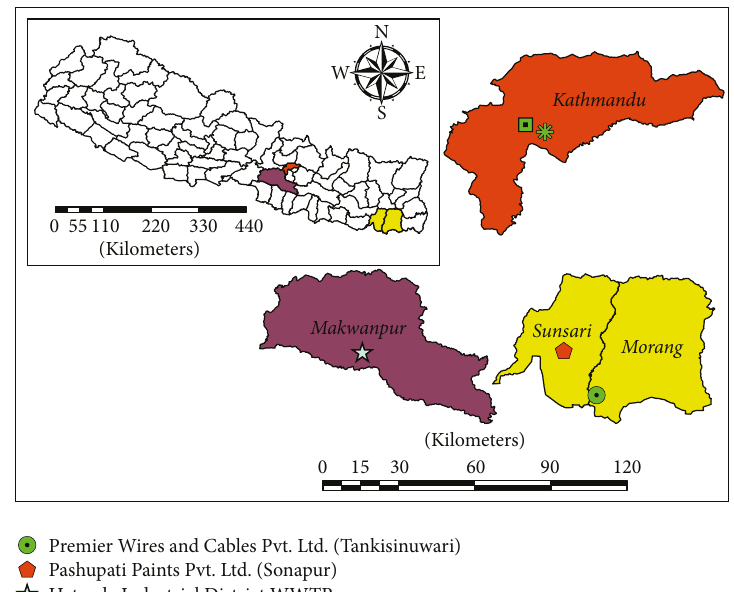
Figure 2: Five sites of this study (Sites 1, 2, 3, 4, and 5) present in 4 districts of Nepal (inset: map of Nepal showing the four districts as